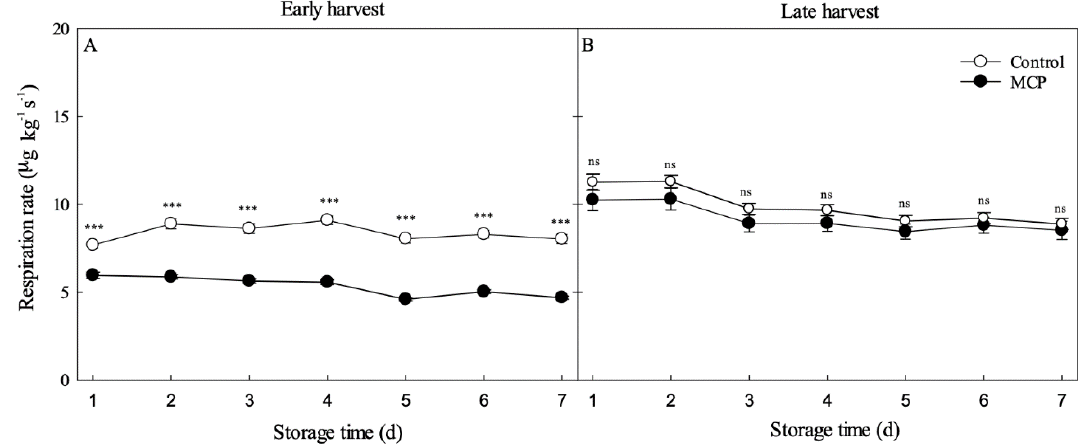
Figure 2. Respiration rate of early ( A ) and late-harvested ‘Empire’ apples ( B ) and stored at 0.5 °C in air storage up to 7 months and evaluated for 7 days at 20 °C. Bars represent error of the means (SEM; n = 5), when larger than the dimension of the symbol. *** Adjacent to each data point for each storage time indicates significant differences as determined by Duncan’s multiple range test at p ≤ 0.001; ns—not significantly different.